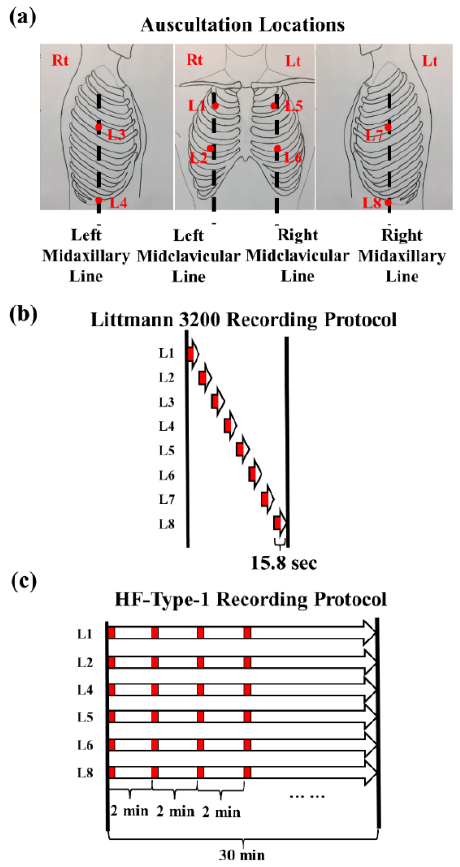
Figure 1. Lung sound auscultation locations and protocol. ( a ) Predefined auscultation locations (L1–L8). ( b ) Littmann 3200 recording protocol. ( c ) HF-Type-1 recording protocol. In ( b , c ), white right arrows and red blocks represent original continuous recordings and truncated 15-s recordings, respectively. This figure is adapted from our previous study under a Creative Commons Attribution (CC BY) license [18].